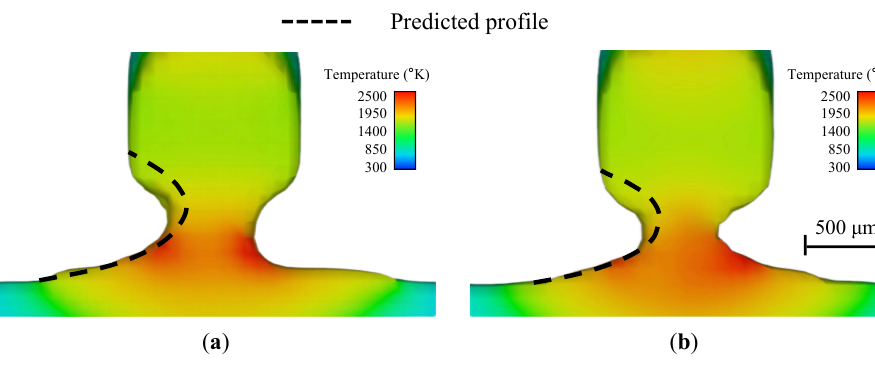
Figure 6. Comparison of the predicted profile (dashed line) and the numerical results for ( a ) wire feed speed of 2 cm/s, ( b ) wire feed speed of 1.34 cm/s.